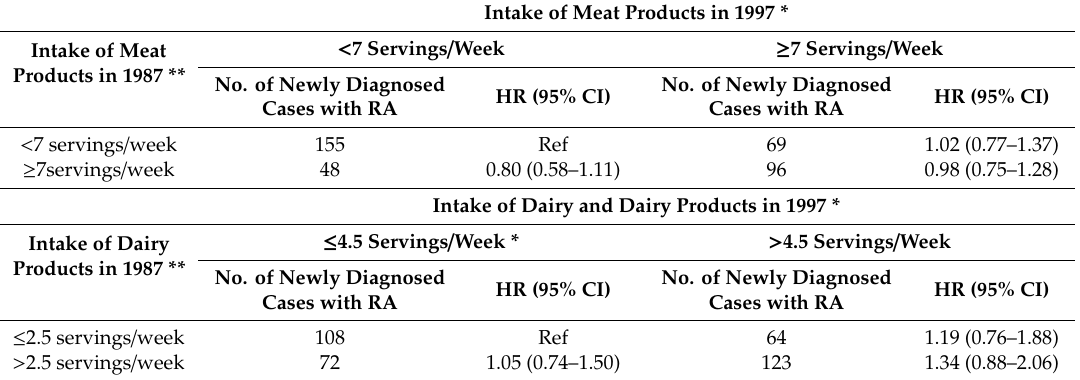
Table 4. Long-term consumption of meat and dairy products between 1987 and 1997 and relative risk of developing rheumatoid arthritis (RA) among women in the Swedish Mammography Cohort during a 12 year follow-up period (January 2003–December